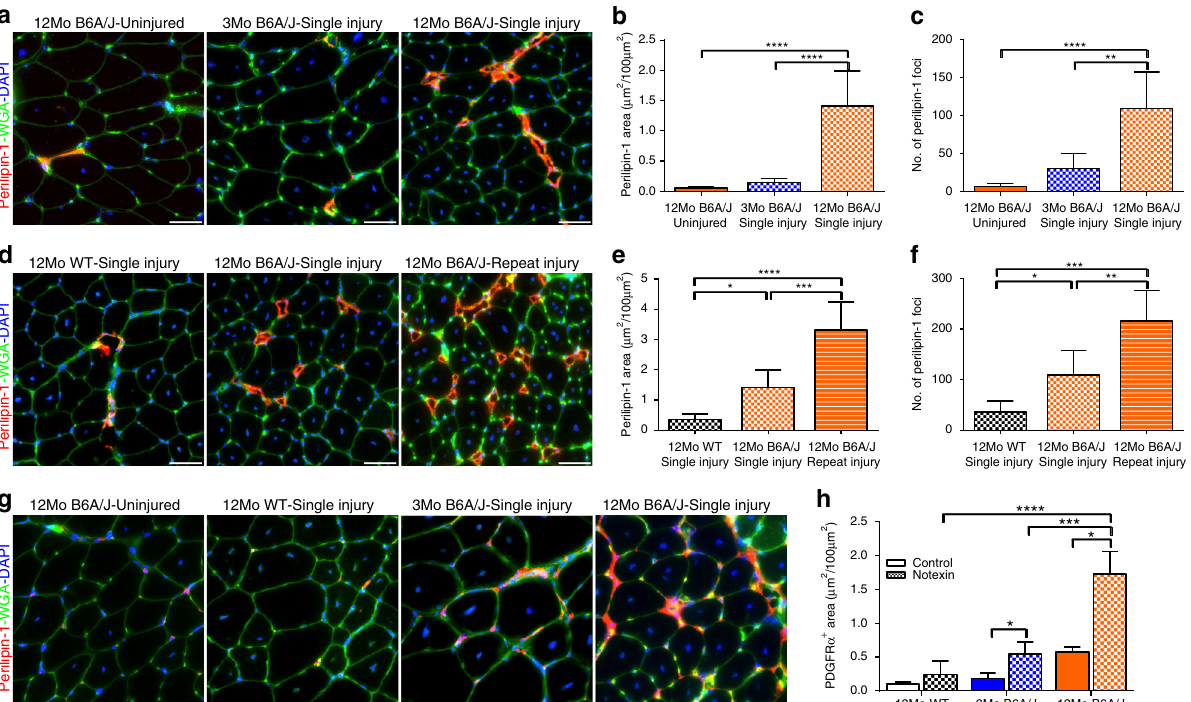
Fig. 3 Injury induces FAP proliferation in older but not younger dysferlinopathic muscle. Images showing Perilipin-1 staining in cross-section of TA muscles from 2 and 12Mo in B6A/J or WT Bl6 mice following 4 weeks after a a single or d three rounds of notexin injury. Scale bar = 50 µ m. Quanti fi cation (mean ± SD) in TA muscle cross-section of b , e total area and c , f number of foci labeled with perilipin-1 after 4 weeks of b , c single or e , f 3-rounds of notexin injury. n = 6 per group. Statistical comparisons performed via ANOVA with Holm – Sidak multiple comparisons test to compare all means with Uninjured 12Mo B6A/J, * p < 0.05, ** p < 0.01, *** p < 0.001, **** p < 0.0001. g Images showing PDGFR α staining after single notexin injury of TA muscle from 12Mo WT, 2Mo and 12Mo B6A/J. Scale bar = 20 µ m. h Quanti fi cation (mean ± SD) of PDGFR α -labeled area of the muscle after notexin injury, n = 6 mice/group. Statistical comparisons between control and notexin injured performed via two-tailed t -test for each group. Comparisons between notexin injured muscles is by ANOVA with Holm – Sidak multiple comparisons test to compare all means with 12Mo WT, * p < 0.05, *** p < 0.001, **** p <